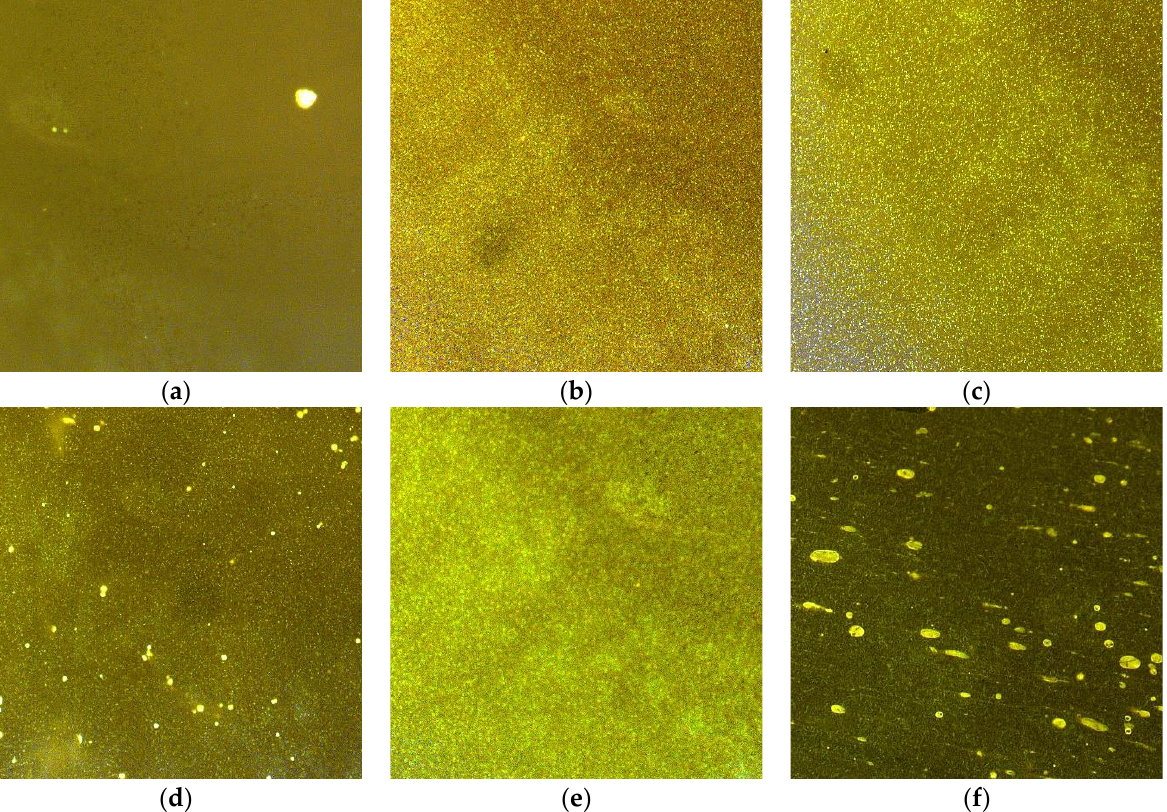
Figure 5. Microstructures of polymer-modified bitumen: ( a ) 2 s ( b ) 4 s ( c ) 6 s ( d ) 8 s ( e ) PMB 45/80-55 ( f ) PMB 45/80-65.